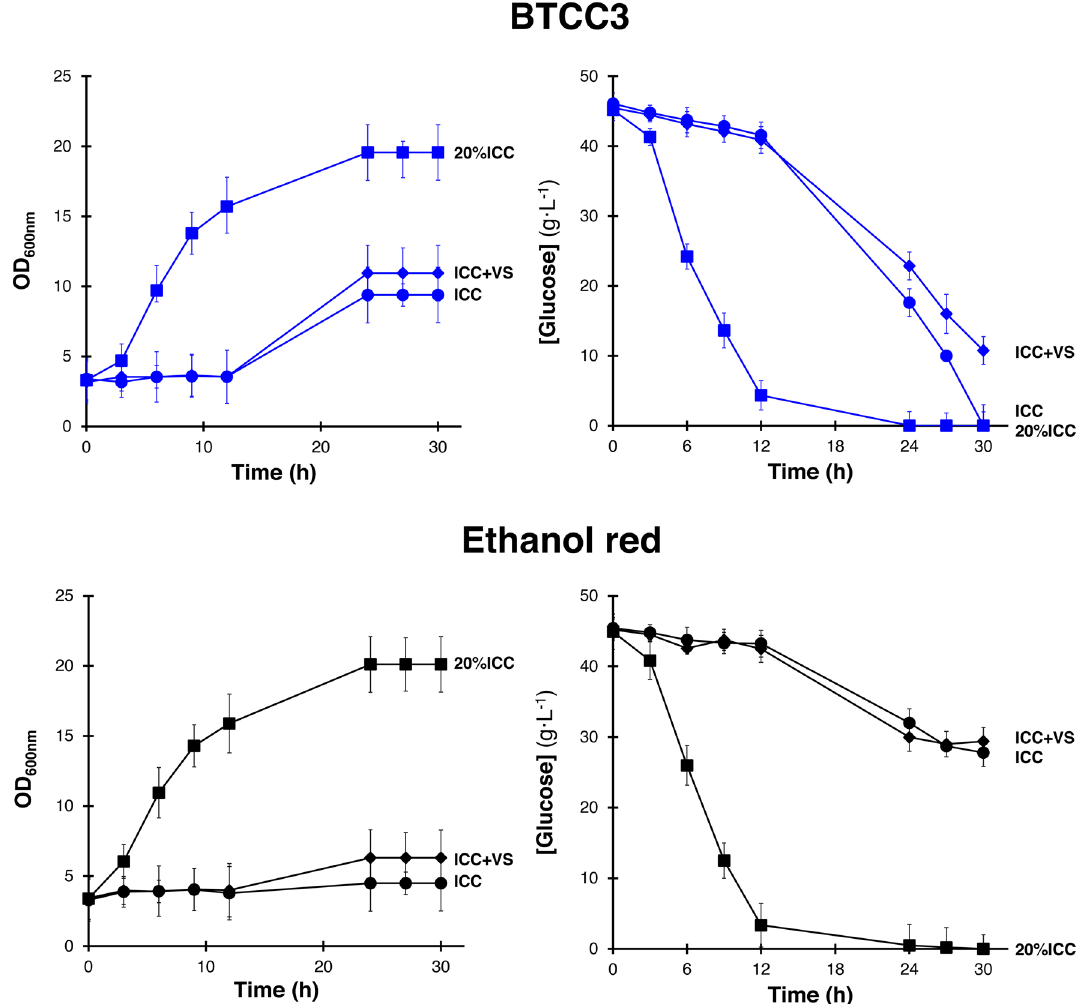
Figure 2. The cell growth and rate of glucose uptake of Saccharomyces cerevisiae BTCC3 strain (blue lines) and Ethanol-red (black lines) in YNB medium supplemented with ICC at 20 % level (20%ICC; squares), ICC at 100% level (ICC; circles), and ICC at 100% level with the addition of 0.6 mM vanillin and 0.4 mM syringaldehyde (ICC + VS; diamonds). Values represent the average measurement of three biological replicates. Error bars represent the standard deviation of